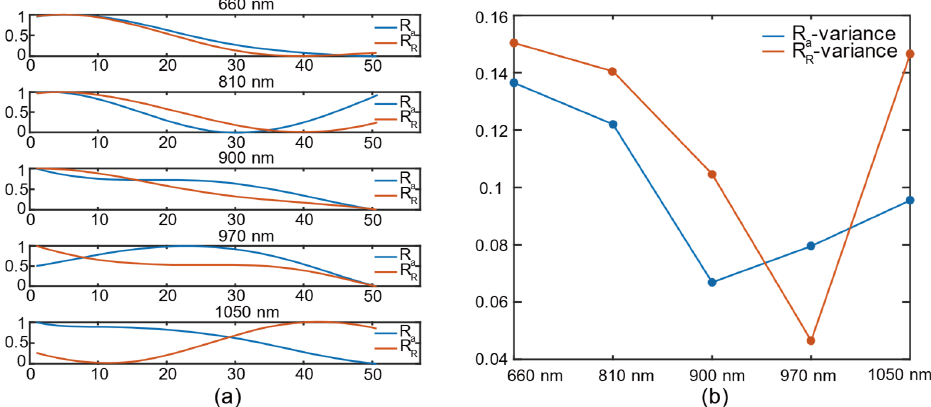
Figure 6. ( a ) Comparison of R a and R R at different wavelengths: 660 nm; 810 nm; 900 nm; 970 nm; 1050 nm; ( b ) variances in R a and R R at different wavelengths.